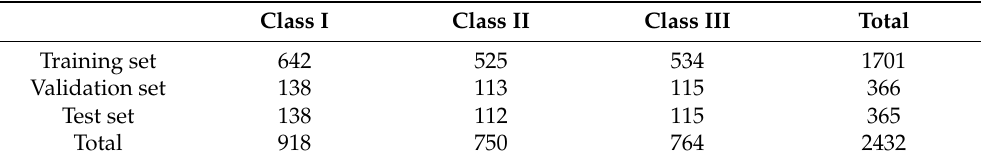
Table 1. Numbers of patients assigned to the training, validation, and test sets of the three sagittal skeletal